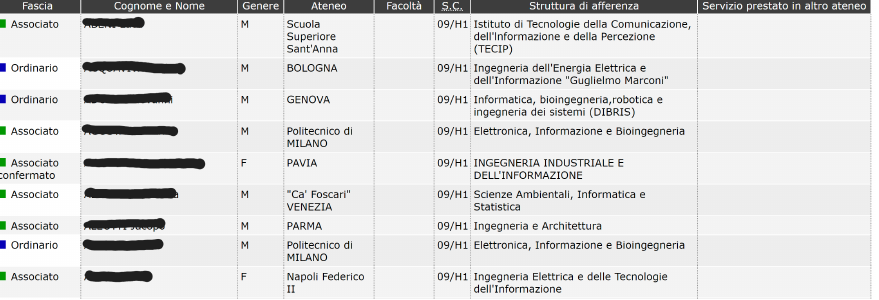
Figure 1. Excerpt of data as provided by MUR. Column labels are role, family and given name, gender, university, school, sector, department, or structure, and note about